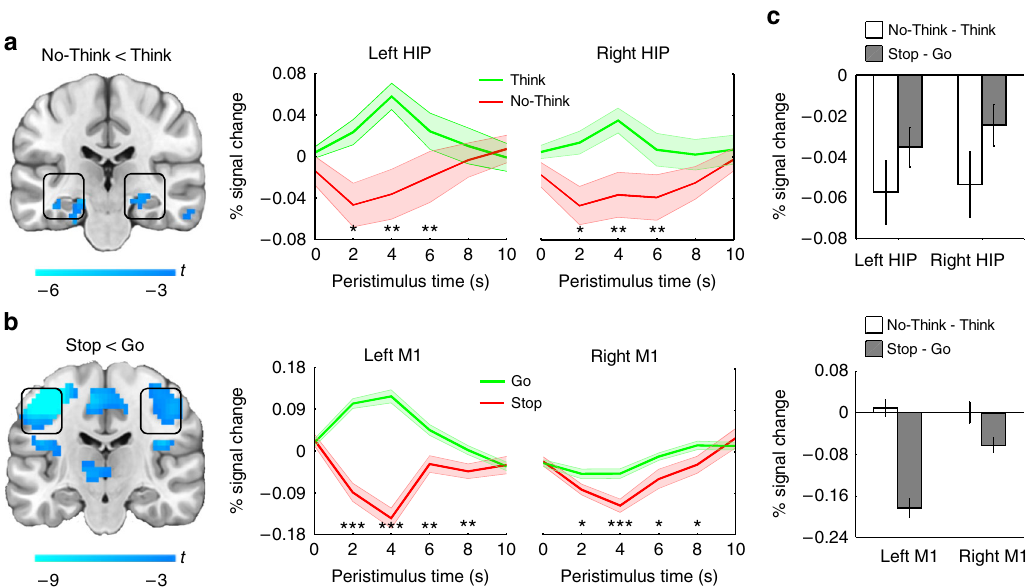
Fig. 1 Domain-speci fi c modulation during thought and action suppression. a and b . Group ( N = 24) whole-brain contrasts for No-Think < Think (top) and Stop < Go (bottom). Thought suppression modulated bilateral hippocampal (HIP) activity. Action-stopping-modulated activity in primary motor cortex (M1), lateralized to the left (contralateral to hand) hemisphere. Boxes illustrate HIP and M1 activations on a coronal slice in MNI space. Activations are derived from an uncorrected cluster-de fi ning threshold ( p < 0.001), with cluster level false discovery rate p < 0.05. Color bars demarcate T -statistics. (Middle panels) A priori region of interest (ROI) analyses: Group hemodynamic time-courses were attenuated in HIP by thought suppression (No-Think) and in M1 by action suppression (Stop) relative to Think and Go, respectively *** p < 0.001; ** p < 0.01; * p < 0.05. c Modality-dependent hemodynamic attenuation in HIP (top) and M1 (bottom) was con fi rmed with a repeated measures ANOVA, which revealed an ROI by Modality interaction. Error bars represent